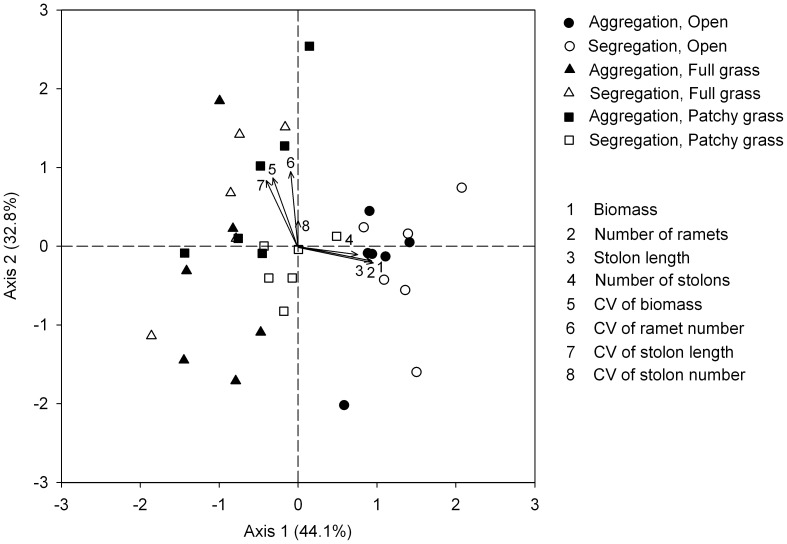
Scatter plot from Principal Component Analysis of the Hydrocotyle vulgaris populations at the whole container level.Axis 1 and 2 explained 44.1% and 32.8% of the total variance, respectively. Response variable scores (arrows) are given.